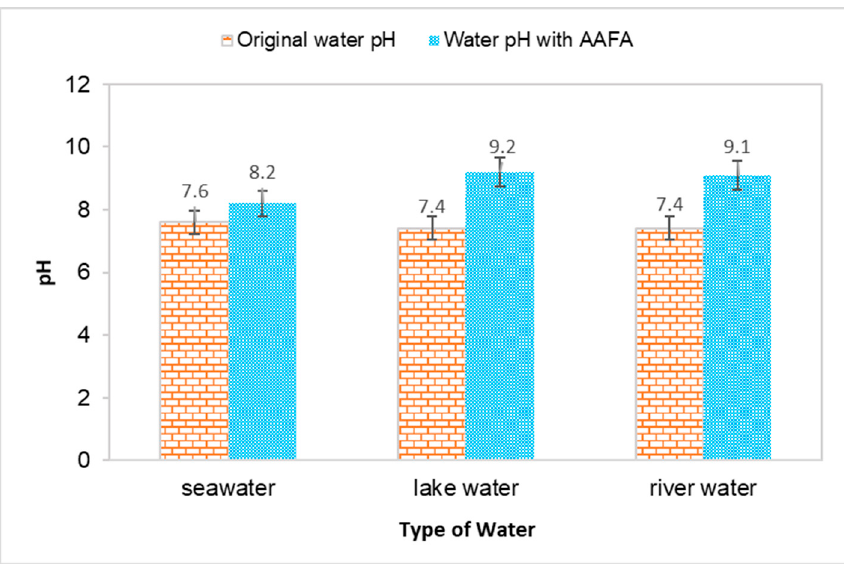
Figure 2. Effect on pH value for different type of water due to placement of the AAFA paste.